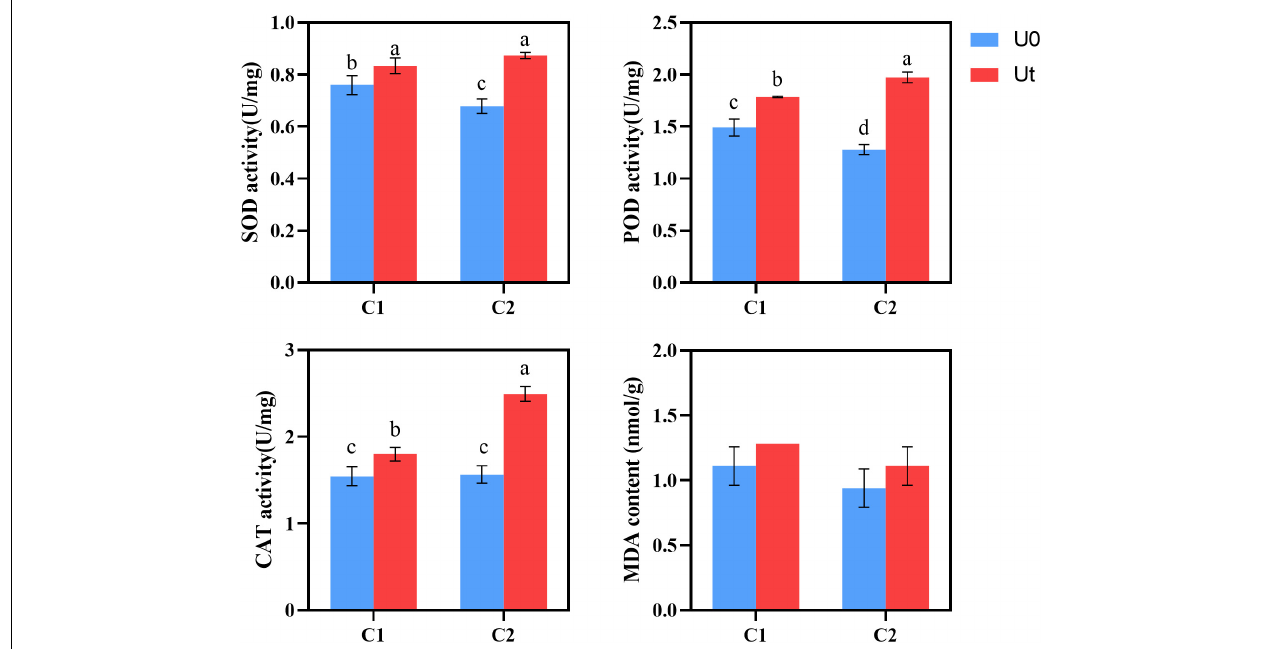
FIGURE 5 | SOD, POD, and CAT activities and MDA content of two Angelica sinensis cultivars in response to enhanced UV-B radiation. Different letters indicated the significant difference ( P < 0.05). Error bars were represented standard deviation